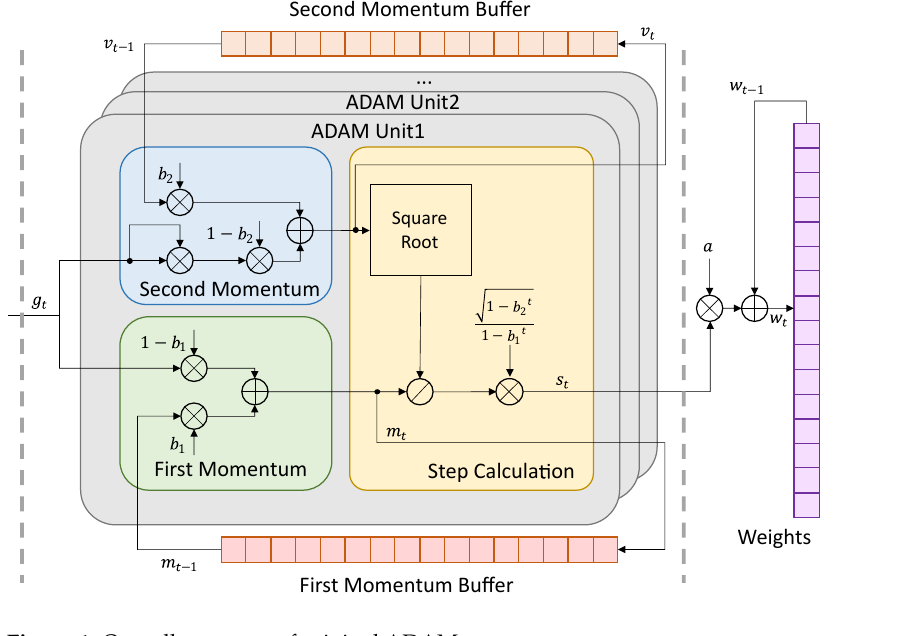
Figure 1. Overall structure of original ADAM. Algorithm 1 The workflow of original